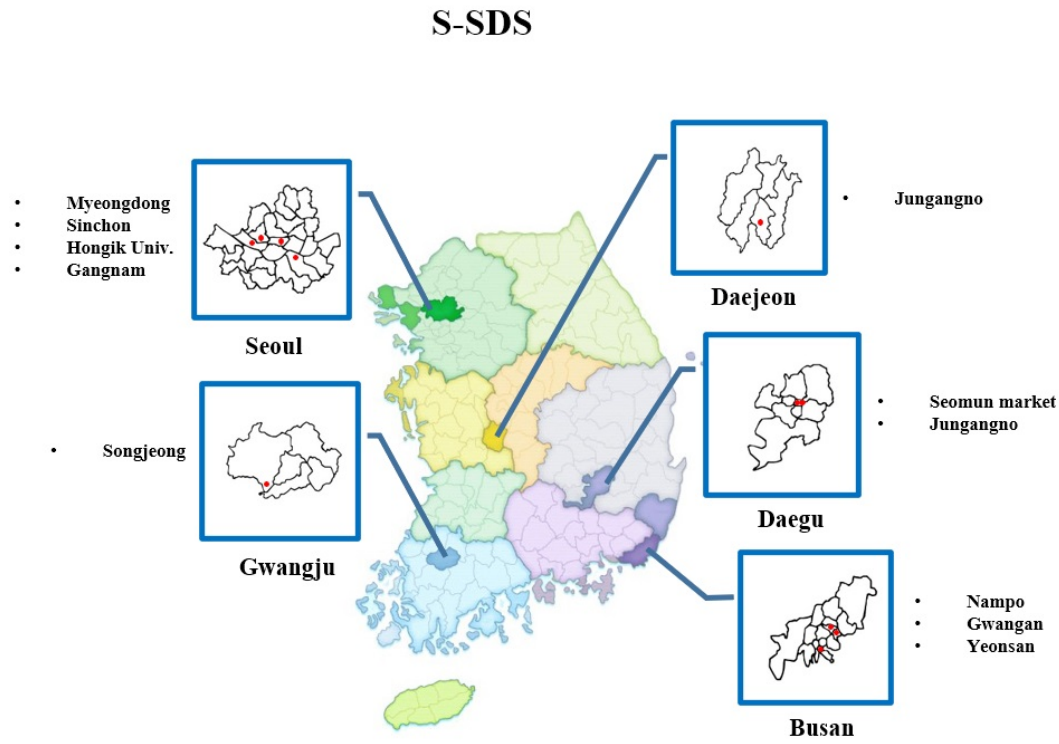
Figure 1. Major subway stations selected to estimate S-SDS. S-SDS was determined based on the number of passengers for 11 major subway stations in five cities of the Republic of Korea. S-SDS, subway use-based social distancing score.